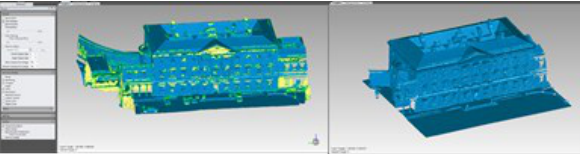
Figure 14: Initial Workflows Involved For Processing Lidar Data